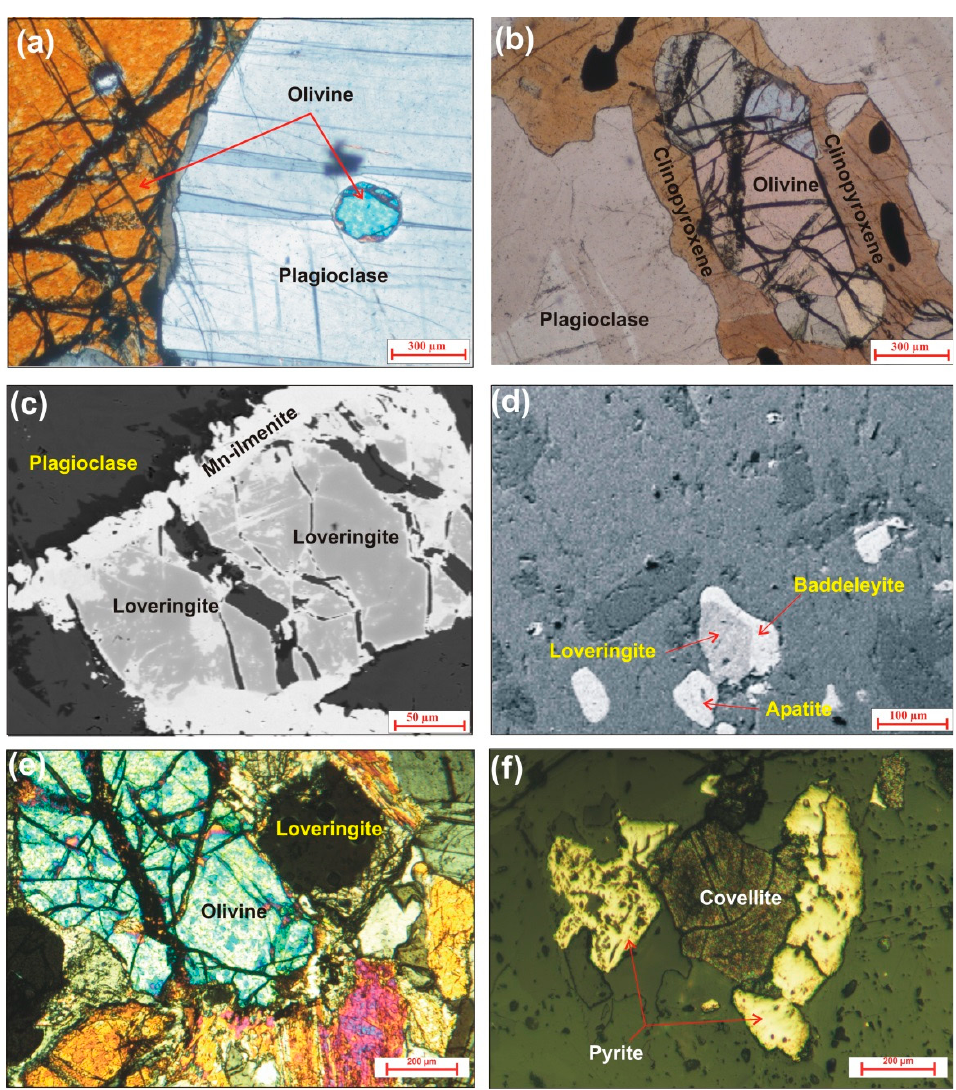
Figure 3. Photomicrographs showing textures and mineral characteristics of olivine gabbro: ( a ) plagioclase containing small, rounded crystals of olivine in cross-polarized transmitted light, ( b ) olivine surrounded by pyroxene forming corona texture in plane-polarized transmitted light, ( c ) backscattered electron image showing loveringite crystal rimmed by ilmenite, ( d ) backscatter image showing apatite and baddeleyite crystals around loveringite, ( e ) secondary minerals such as amphibole and chlorite surrounding loveringite in cross-polarized light, and ( f ) sulfide minerals in reflected light.